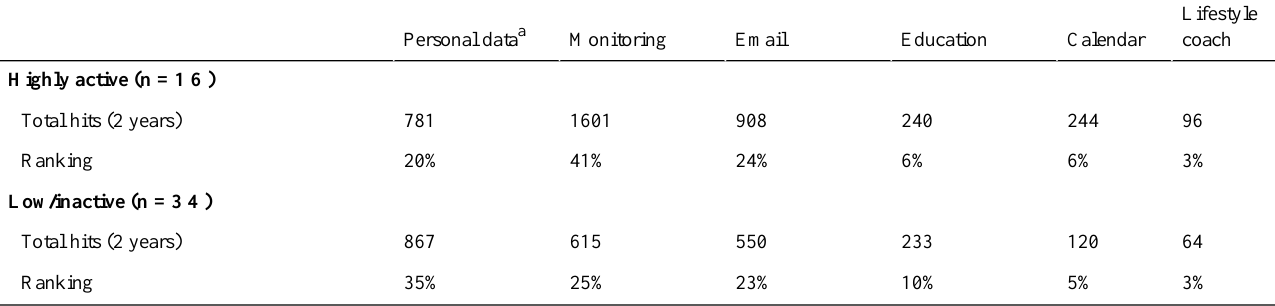
Table 5. User activity related to the use of system features: ranking of the features